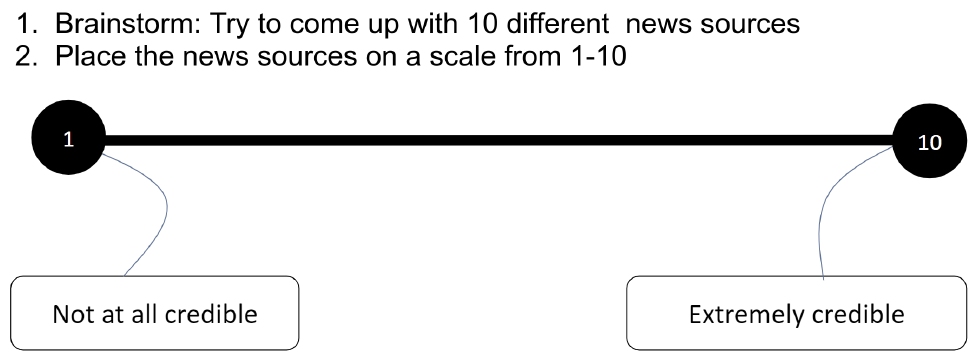
Figure 2. Pupil active group task designed to stimulate conversation and link the educational content to pupils’ perceptions of